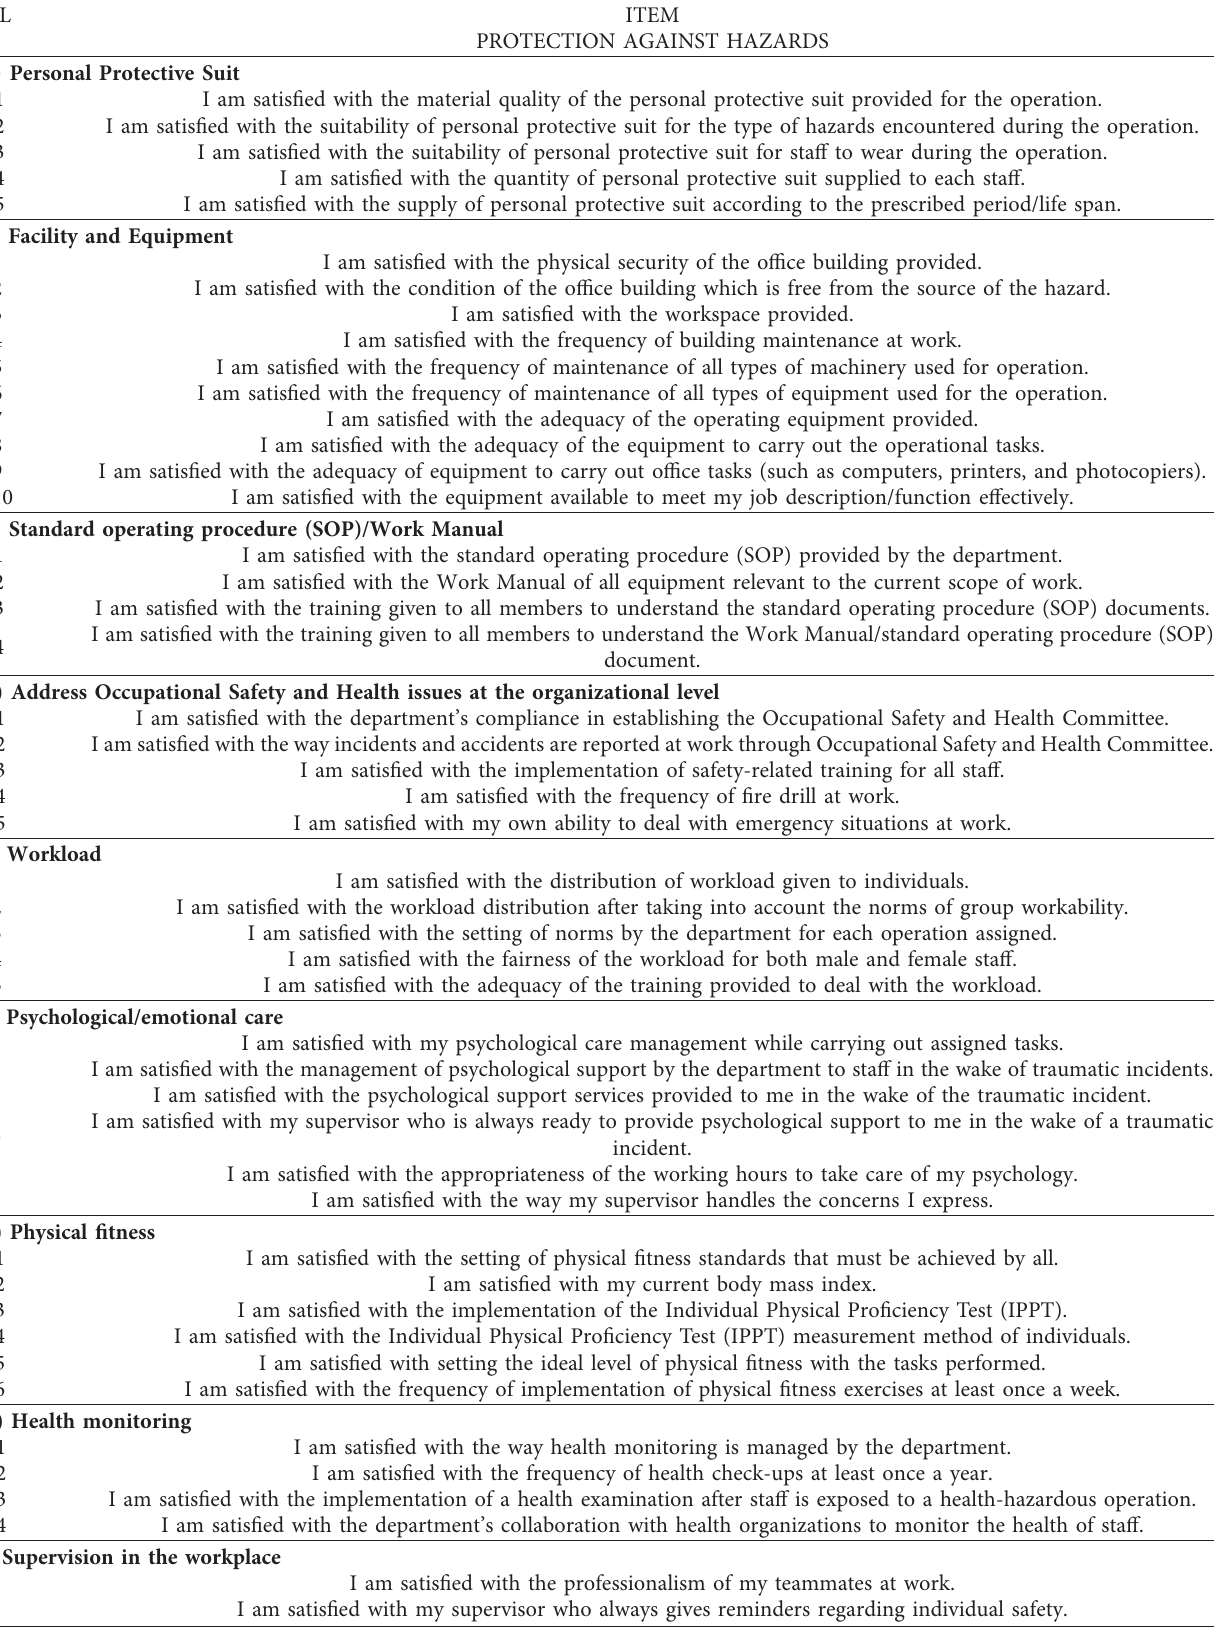
Table 1: Items of the SSI and HC scale after exploratory factor